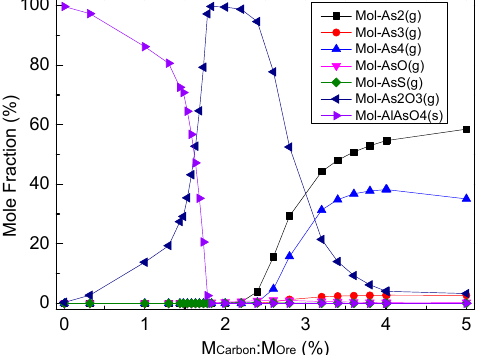
Figure 8. Effect of carbon ratio on arsenic removal products of dust ash by roasting.